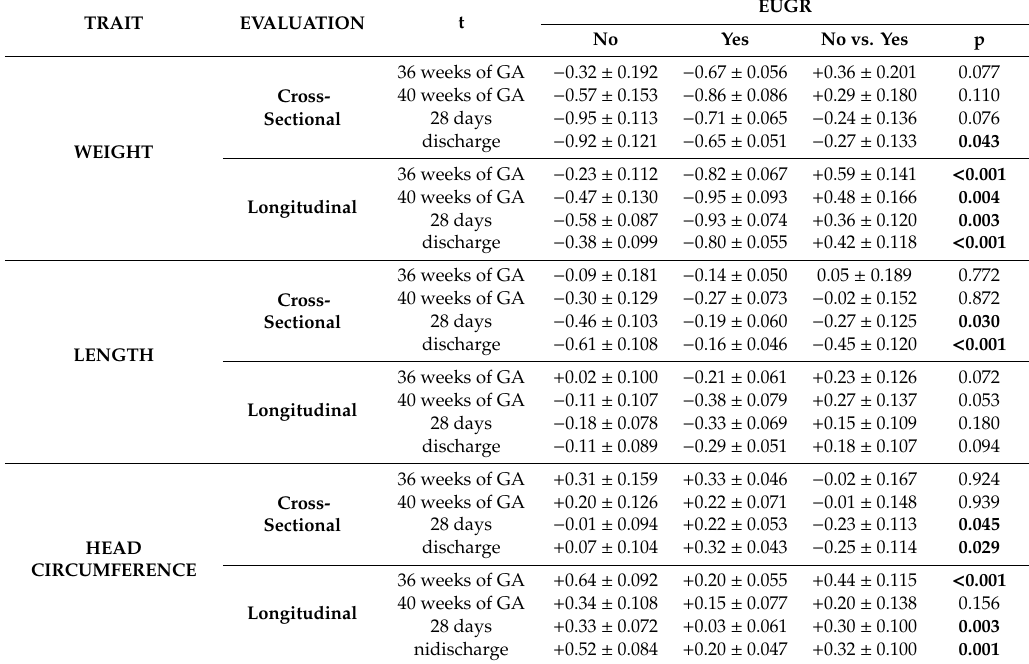
Table 5. ∆ SDS (SDS 24–30 months –SDS at birth) LS means ± Standard Error in EUGR and non-EUGR group. EUGR was defined using weight in cross-sectional and longitudinal way at the four t-times.